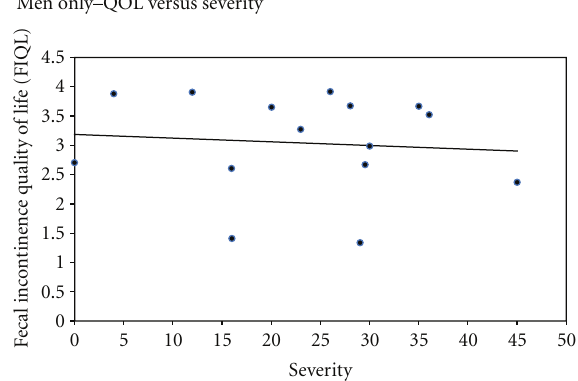
Figure 3: Quality of life as a function of severity of fecal inconti- nence in men ( P = 0 .